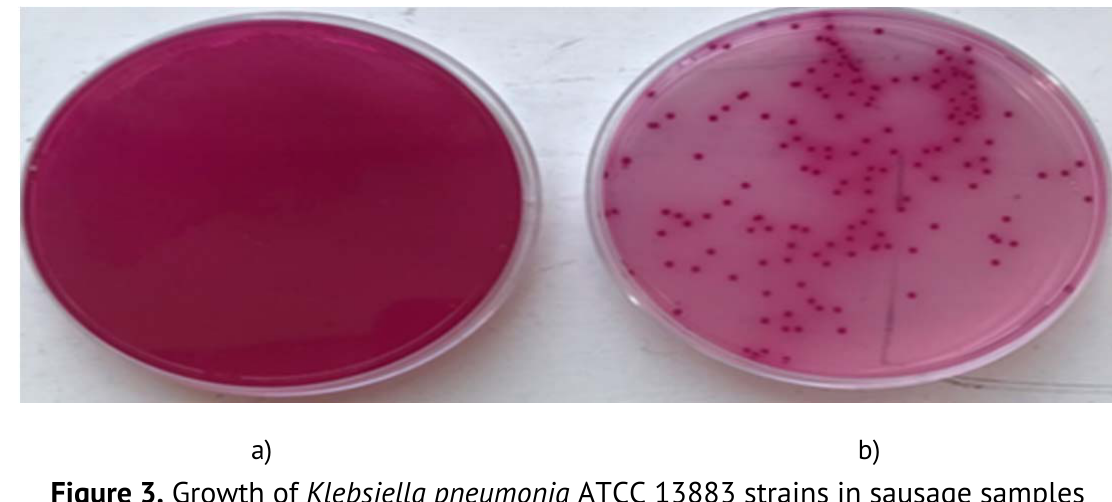
Figure 3. Growth of Klebsiella pneumonia ATCC 13883 strains in sausage samples tested after 48h: a) control sample; b) hawthorn